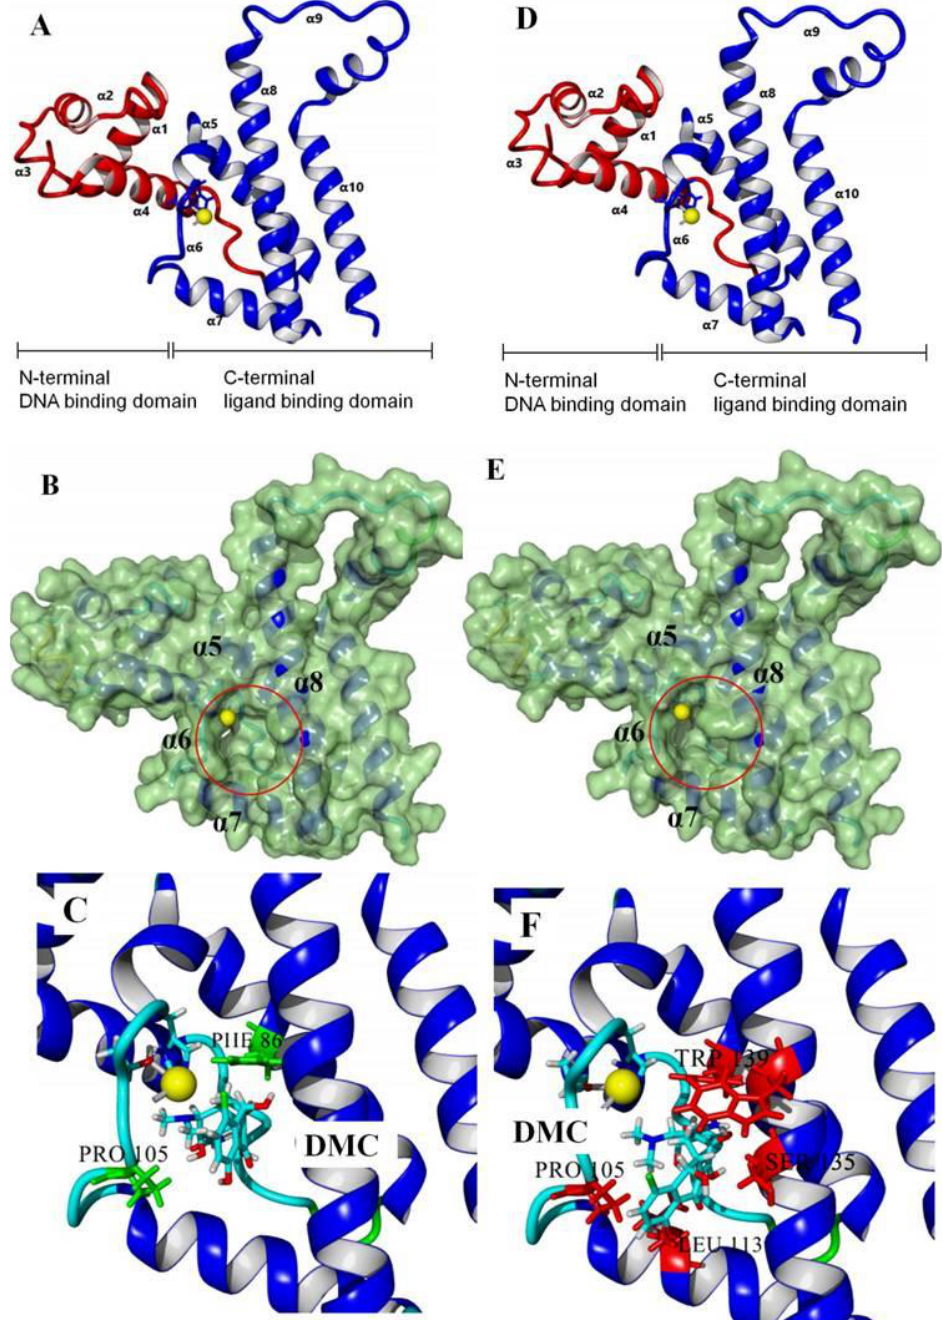
Figure 2. ( A ) The 3D structure of the natural TetR, ( B ) its binding pocket, and ( C ) its docking complex with DMC. ( D ) The 3D structure of the mutant, ( E ) its binding pocket, and ( F ) its docking complex with DMC.